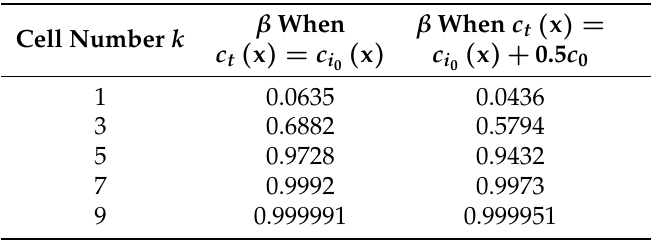
( x ) (the corresponded 0